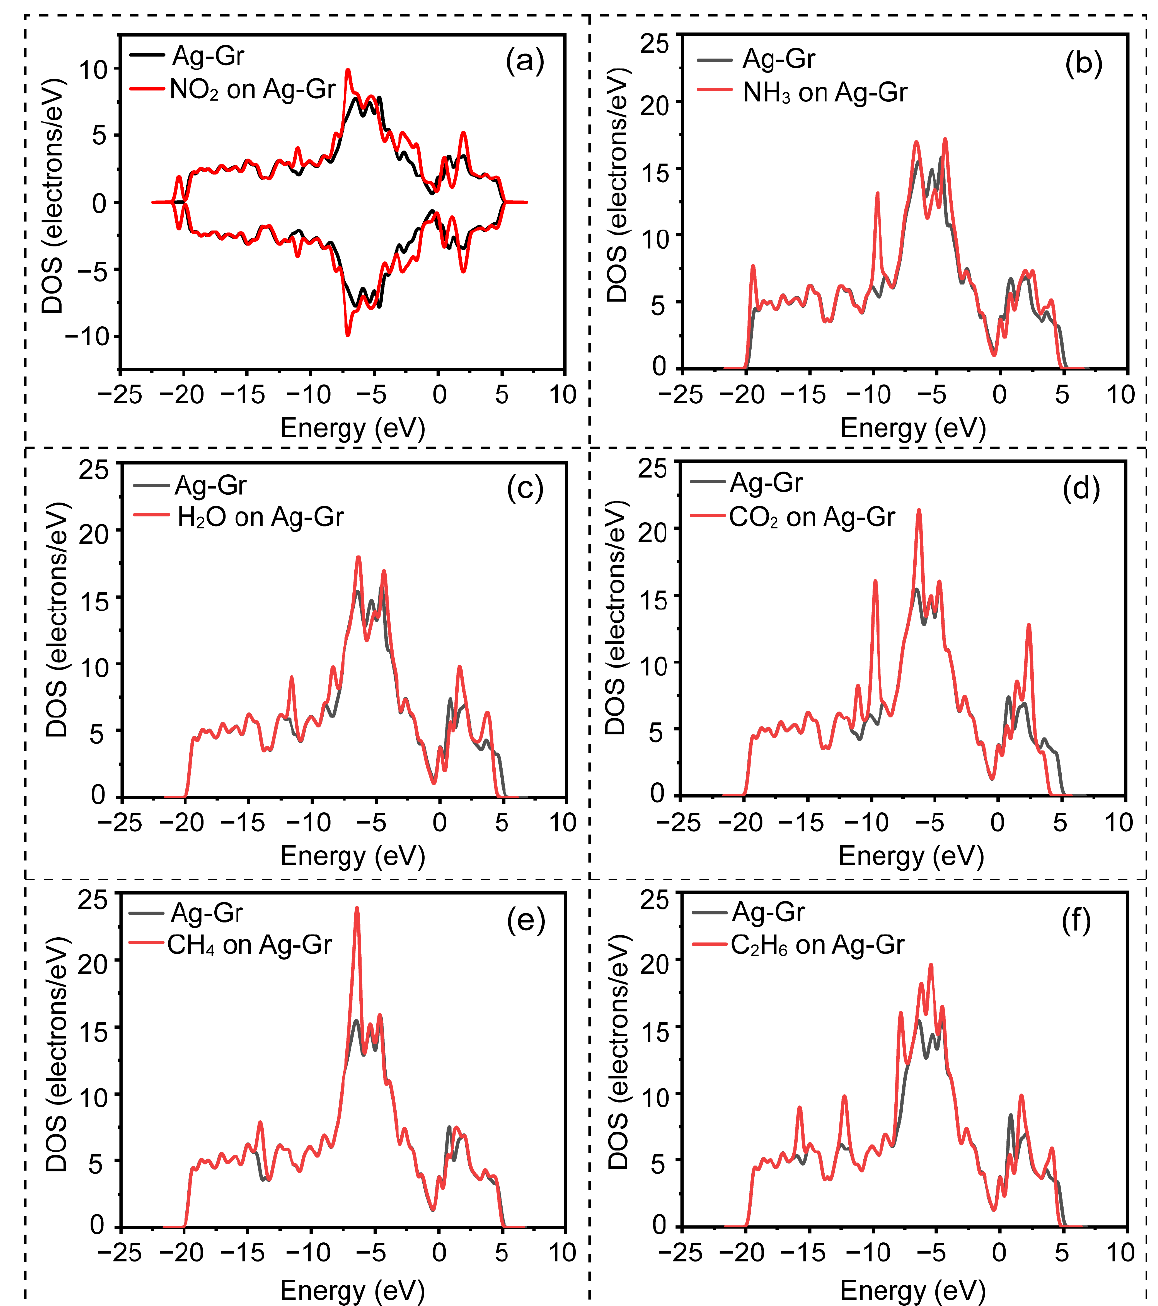
Figure 2. The DOS comparison of Ag–Gr and Ag–Gr adsorption with ( a ) NO 2 , ( b ) NH 3 , ( c ) H 2 O, ( d ) CO 2 , ( e ) CH 4 , and ( f ) C 2 H 6 .